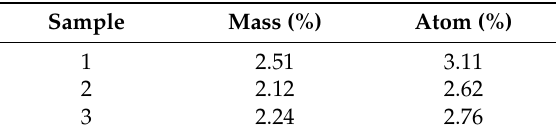
Figure 1. Scanning electron microscope (SEM) image ( a ) and the size distribution; ( b ) of the Cu–V composite power; ( c ) the energy dispersive spectrometer (EDS) result (point scanning) from certain particles; the “k” on y-axis means thousand. Table 1. V content of selected particles.